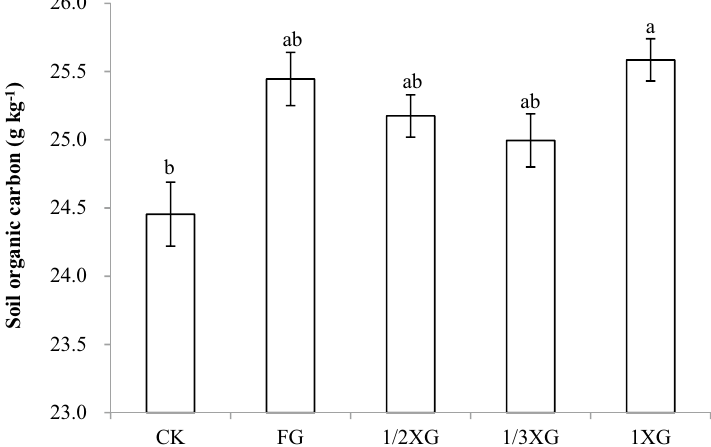
Figure 1. Effect of straw returning on soil organic carbon content. CK control (stubble remaining in soil), FG full straw mulching, 1 XG full straw returning combined with rotary tillage, 1/2 XG 1/2 of full straw returning combined with rotary tillage, 1/3 XG 1/3 of full straw returning combined with rotary